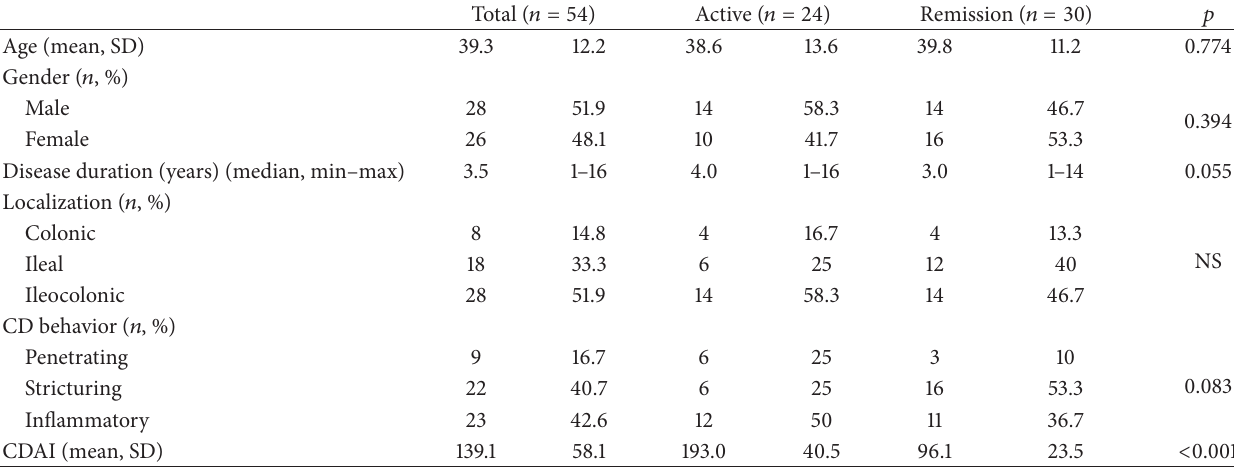
Table 1: Demographics and baseline characteristics.